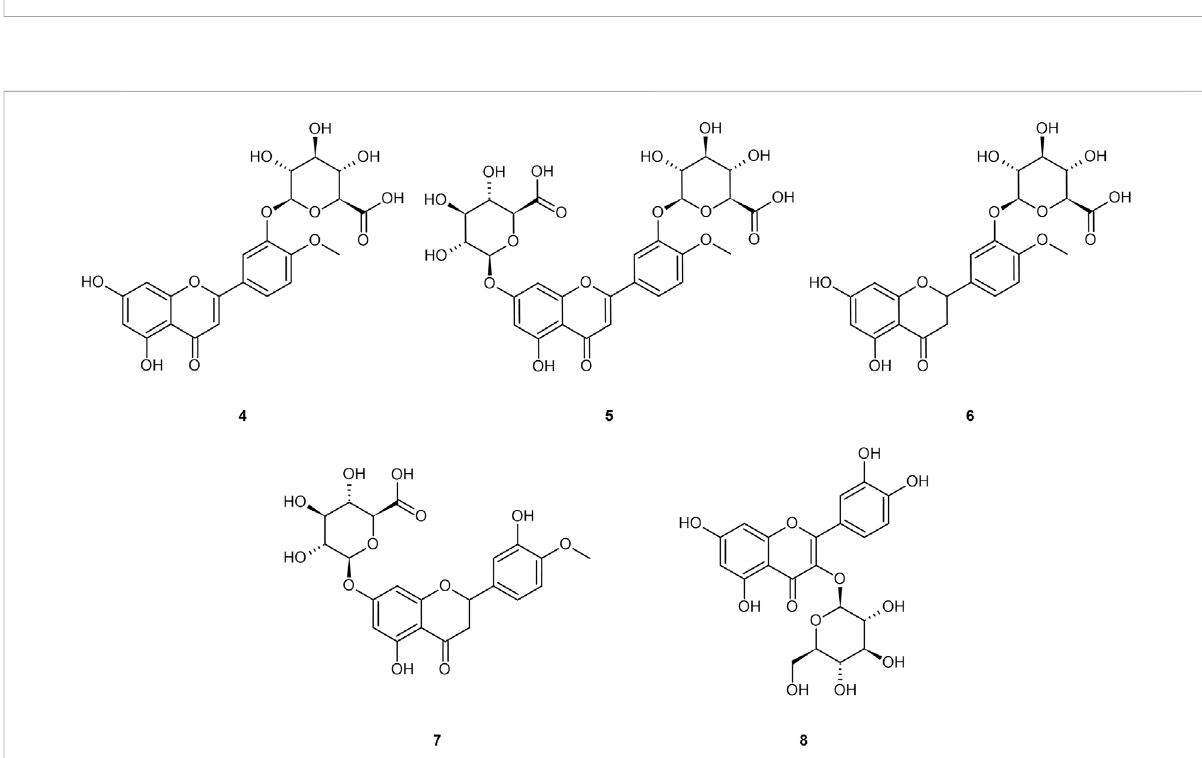
FIGURE 2 Common glucuronide metabolites of the referenced aglycones: diosmetin-3 ′ -O-glucuronide (4) ; diosmetin-3 ′ -7-O-glucuronide (5) ; hesperetin-3 ′ -O-glucuronide (6) ; hesperetin-7 – O-glucuronide (7) ; quercetin-3-O-glucuronide (8)